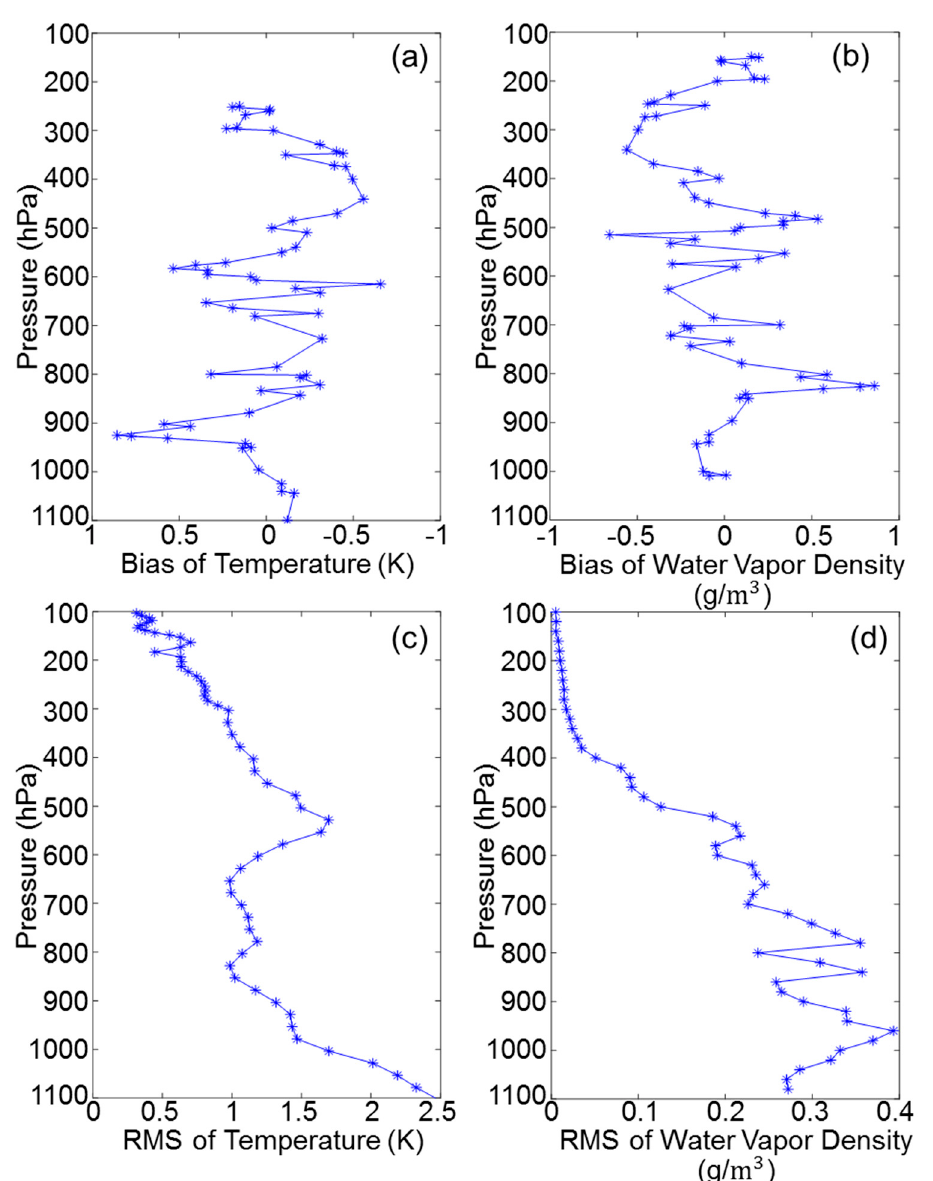
Figure 11. The biases and root mean square (RMS) errors of temperature and water vapor retrievals using the combined method during hurricane Matthew: ( a ) bias of temperature; ( b ) bias of water vapor density; ( c ) RMS error of temperature; and ( d ) RMS error of water vapor density.